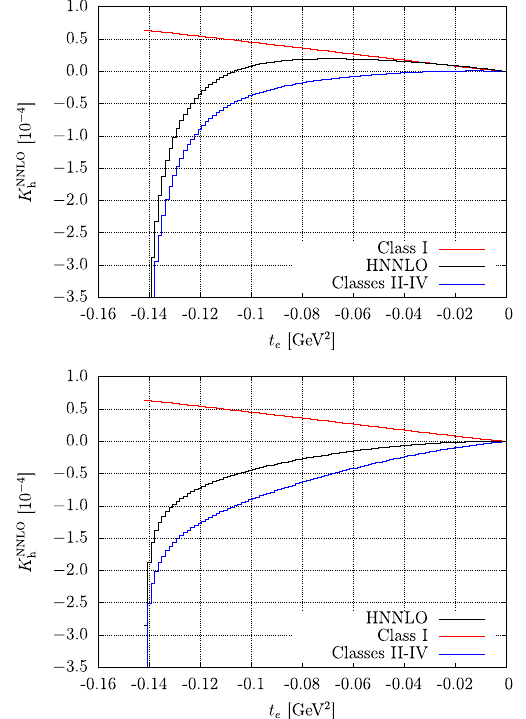
( t ) factor for a positive (upper panel) and negative Fig. 11 K NNLO e h (lower panel) muon beam of energy E 1 = 150 GeV. The total hadronic NNLO correction are depicted in black, while the contributions of class I (II–IV) are shown separately in red (blue) a different Π h ( q 2 ) whose values are given by the R ratio via the dispersion